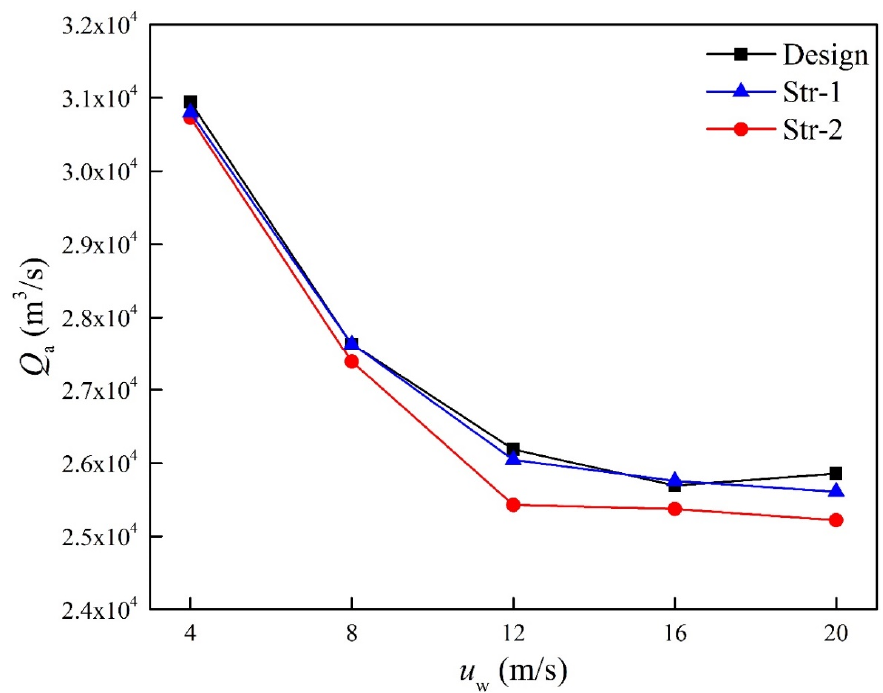
Figure 13. Total volumetric flow rates of fans for Design, Str-1, and Str-2 cases under windy conditions.